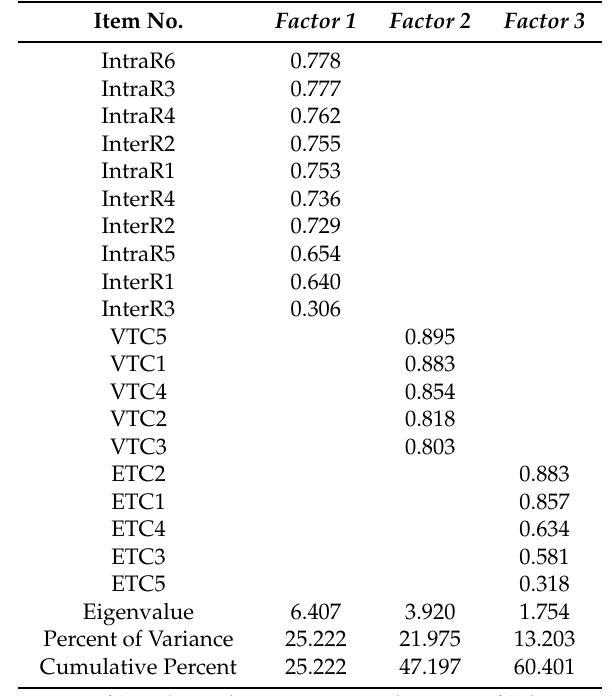
Table 4. Factor analysis